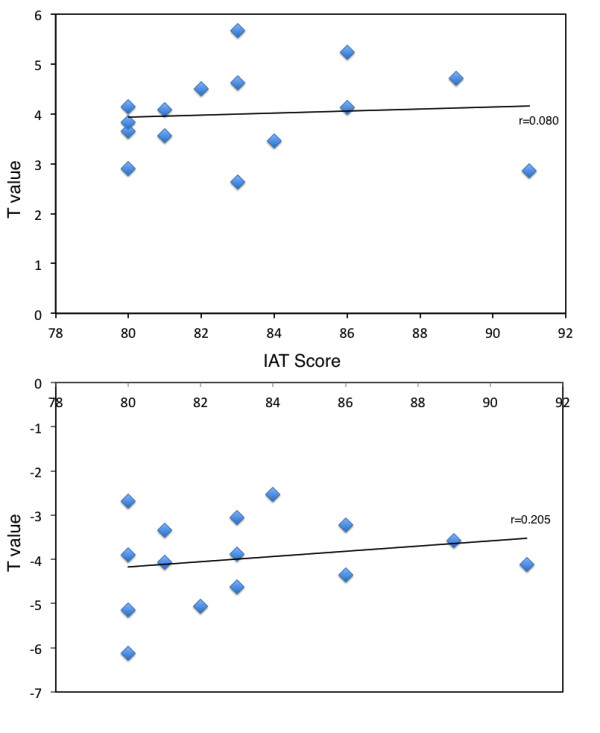
Correlation between the mean peak values survived after correction (hyper-activation) and IAT scores (upper); Correlation between the mean peak values survived after correction (hypo-activation) and IAT scores (bottom).